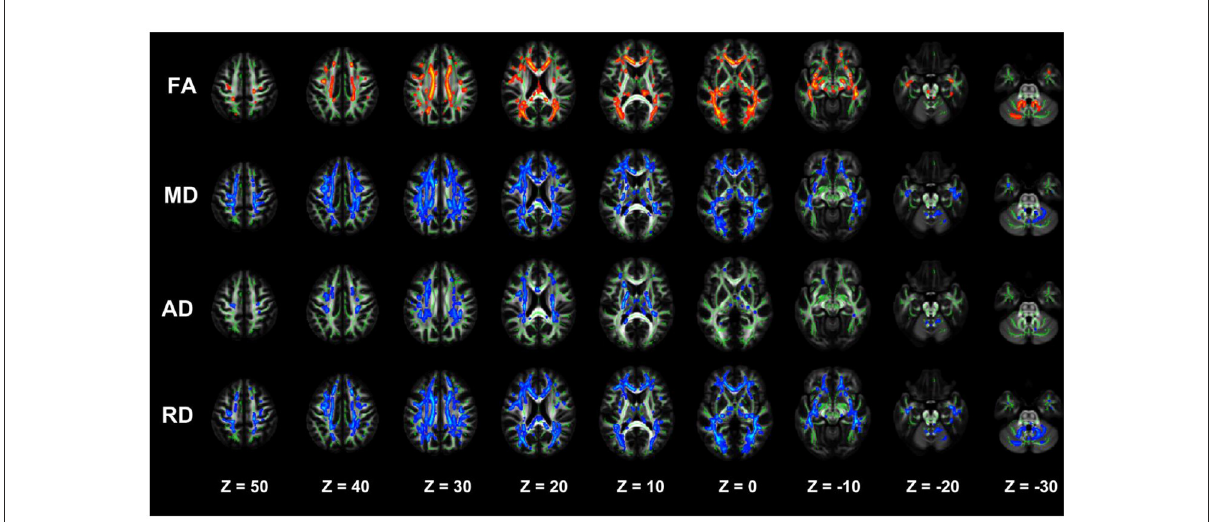
FIGURE1 TBSS analysis showing abnormal white matter bundles in areas with differences in DTI parameters, including the FA, MD, AD, and RD, between the NDD-CKD and NC groups. Red color indicates significantly increased white matter bundle parameters, and blue color indicates significantly decreased white matter bundle parameters. Green color represents the mean FA frame for all subjects. FA, fractional anisotropy; MD, mean diffusivity; AD, axial diffusivity; RD, radial diffusivity; TBSS, tract-based spatial statistics; DTI, diffusion tensor imaging.